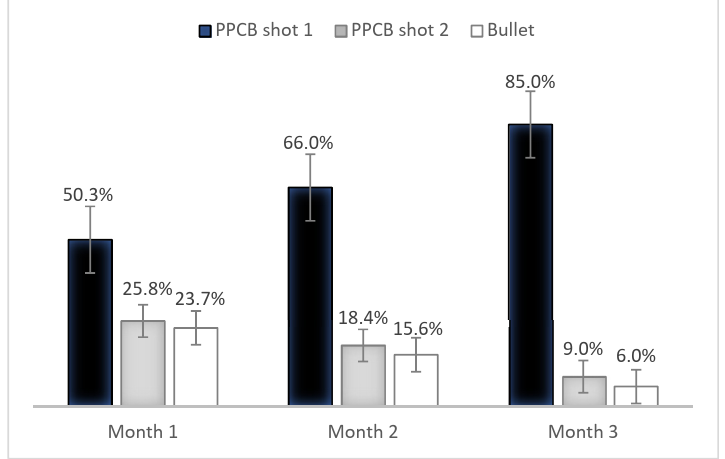
Figure 3. Frequencies of stunning effectiveness during the first phase of the study. Standard error bars are presented.